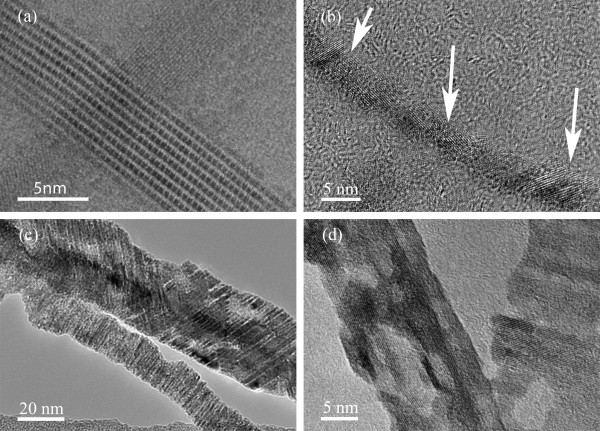
TEM image of Mo NW and bundles. (a) TEM of small MoSI NW bundle. (b) High resolution TEM image of Mo NW with a diameter of approximately 5 nm. The arrows point at the grain boundaries where NW can be flexible to elastic structural deformation (c) and (d) show TEM images for large diameter Mo NWs (>15 nm) with significant surface roughness. The pore formation is clearly visible as hollow voids of various sizes that are incorporated in the bulk and the surface structures.